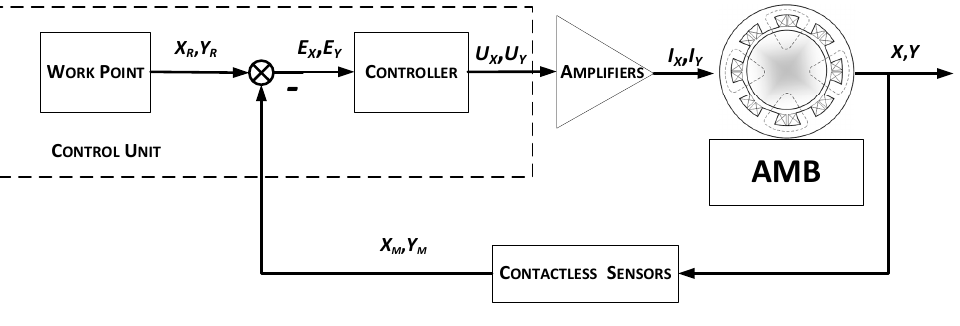
Figure 2. Operation algorithm of single AMB.